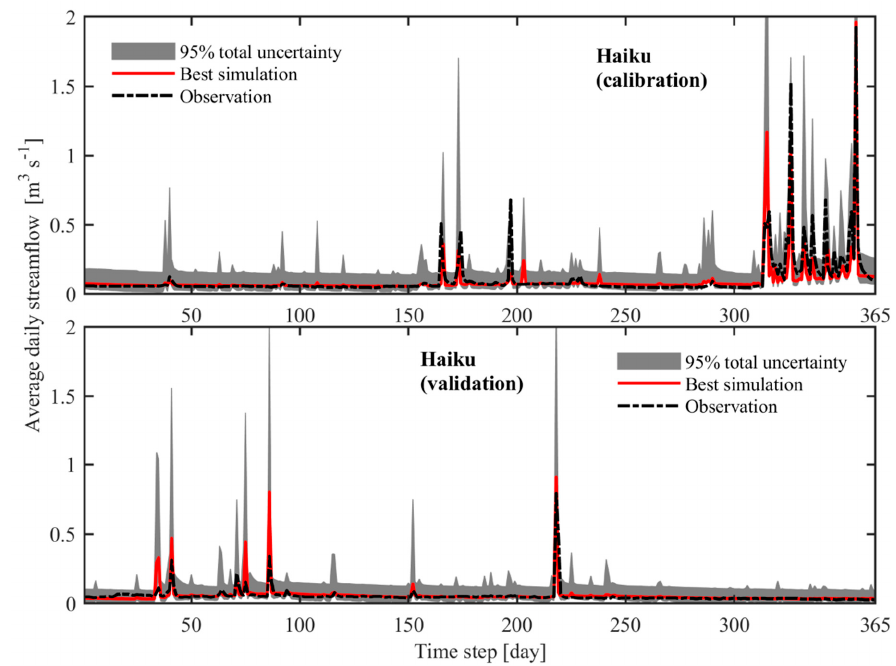
Figure 4. The simulated and observed daily streamflow with 95% prediction uncertainty at the Haiku station for one year of the calibration (2005) and validation (2010) period. Hydrology 2020 , 7 , x FOR PEER REVIEW